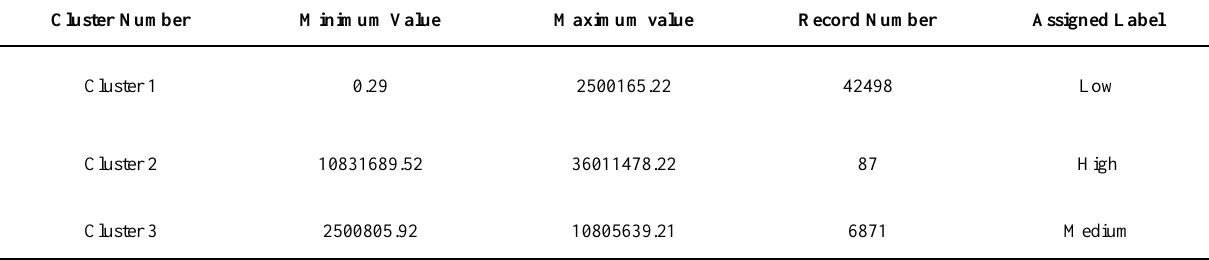
Table 3. Results of clustering on Average ATM transactions.